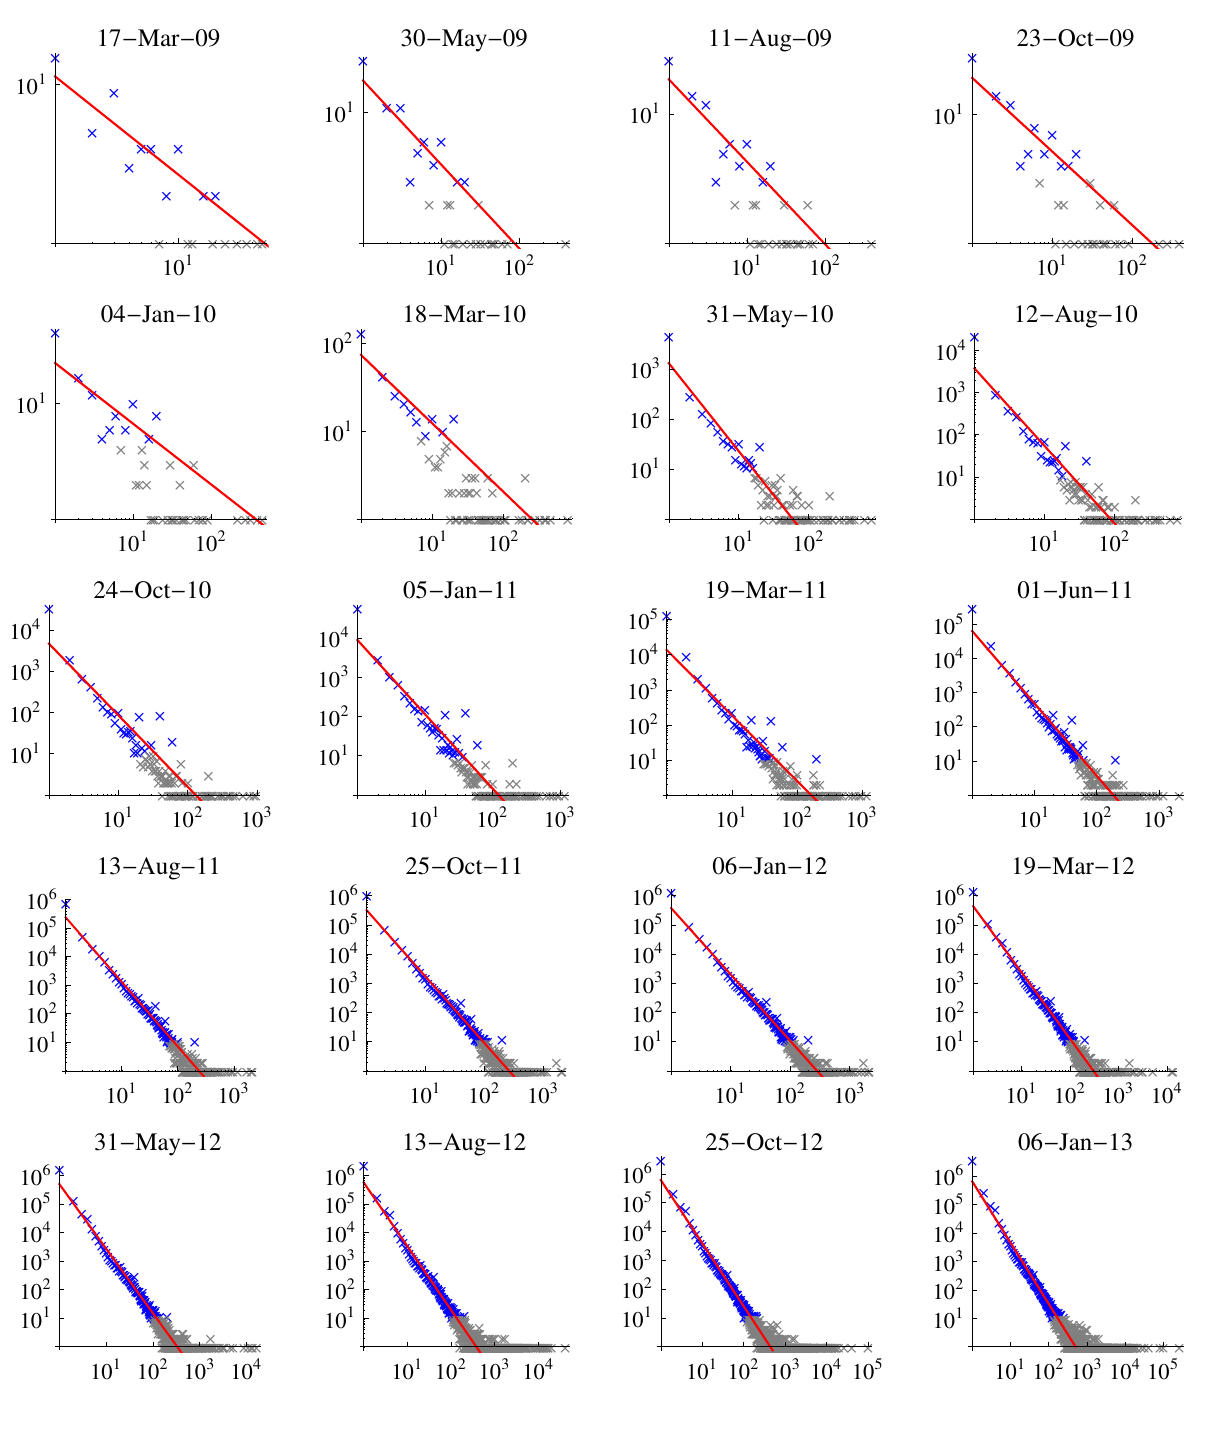
Figure 3. Number of entities ( y -axis) vs . size ( x -axis). Depicted in blue are data points and in red the fit to the blue points; gray values indicate data points ignored in the fit due to small sample